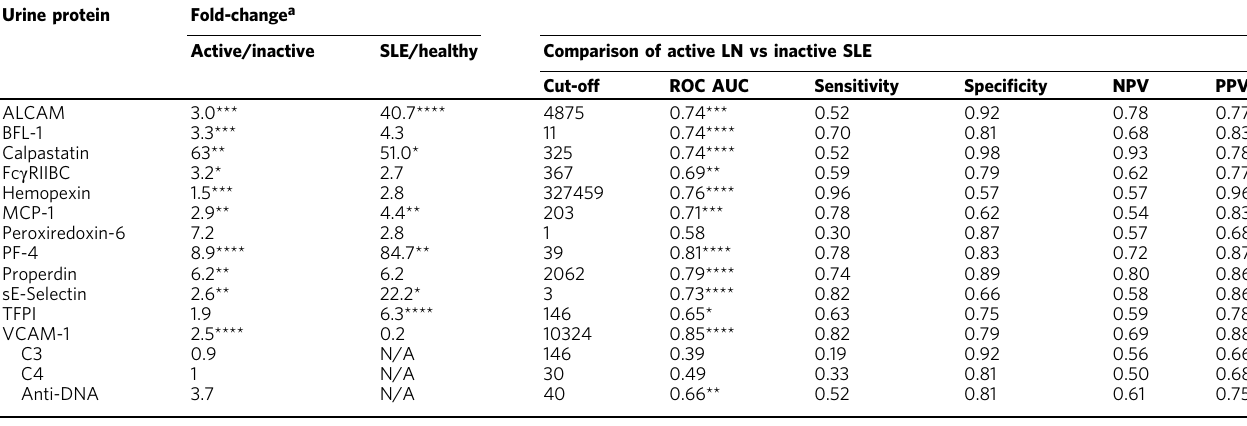
Table 3 Urine Cr-normalized biomarker levels in a primary validation cohort. Urine